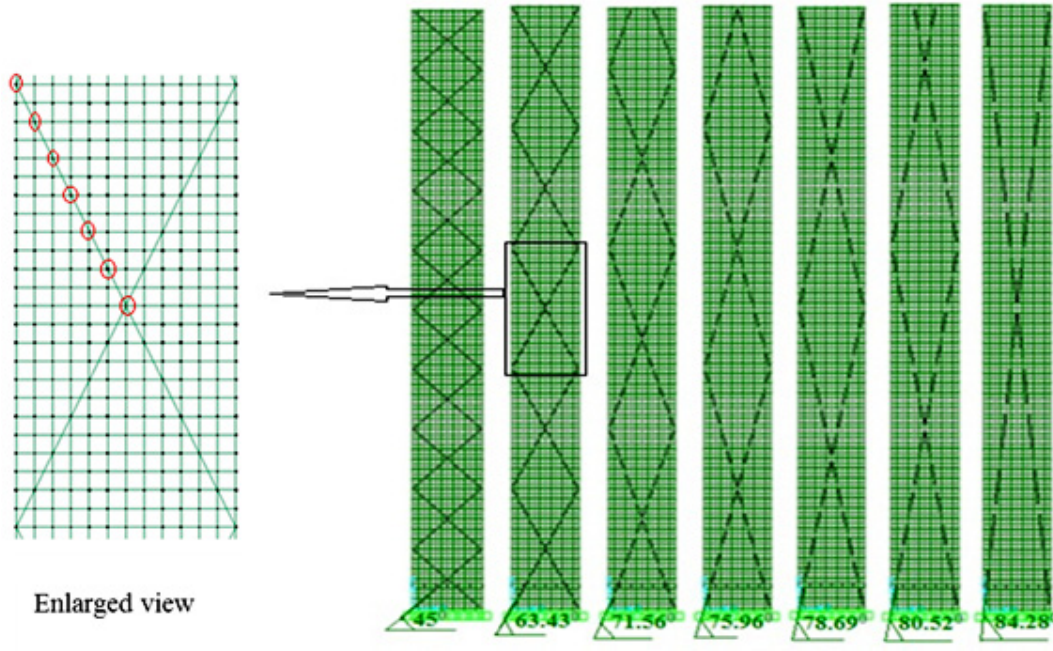
Figure 8. Buildings of Model 1. Different alignments of bracings in 120-story high buildings are